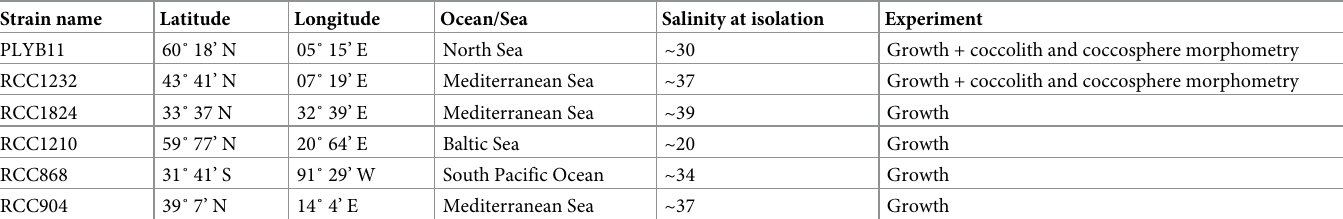
Table 1. List of Emiliania huxleyi strains cultured in this